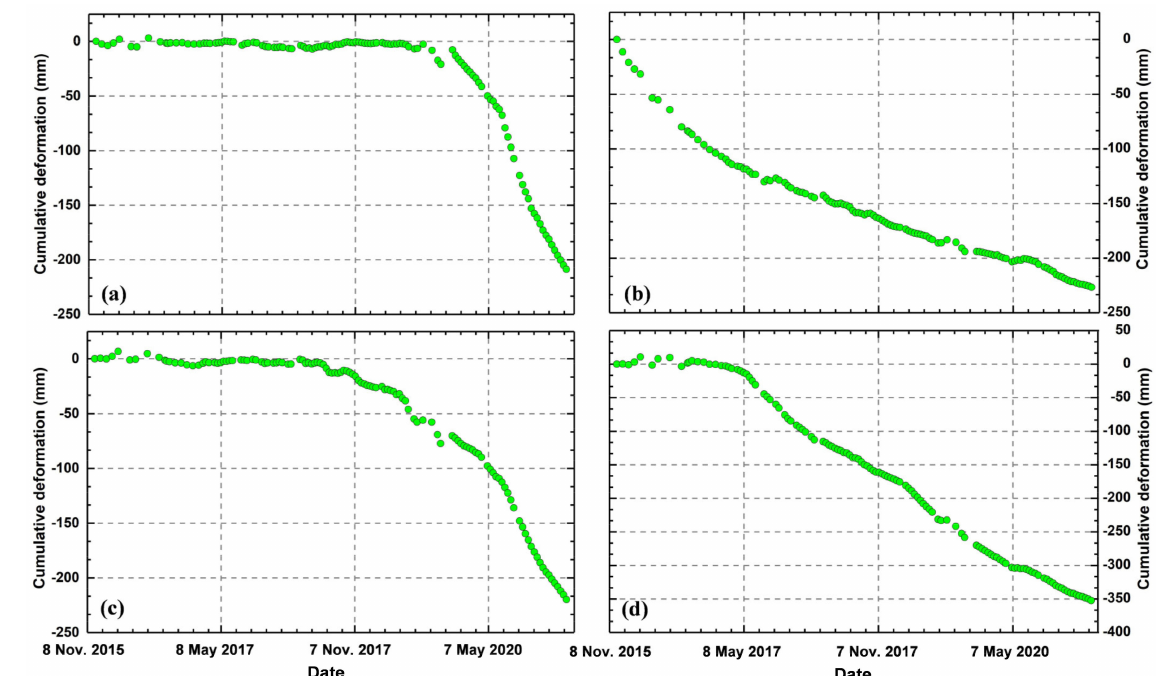
Figure 23. Time series of the surface displacement at Points P3–P6 from December 2015 and March 2021, the locations of Points P3–P6 are marked in Figure 21. ( a ) Displacement time series for Point P3 marked in Figure 21b; ( b ) displacement time series for Point P4 marked in Figure 21c; ( c ) displacement time series for Point P5 marked in Figure 21c; ( d ) displacement time series for Point P6 marked in Figure 21d.